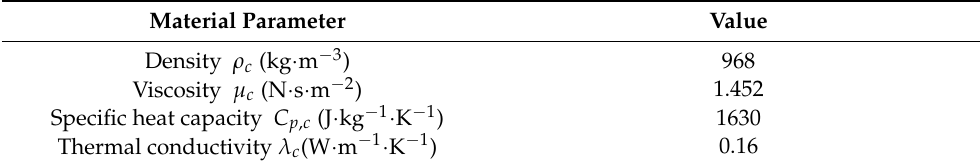
Table 7. Material parameters of dimethyl silicone